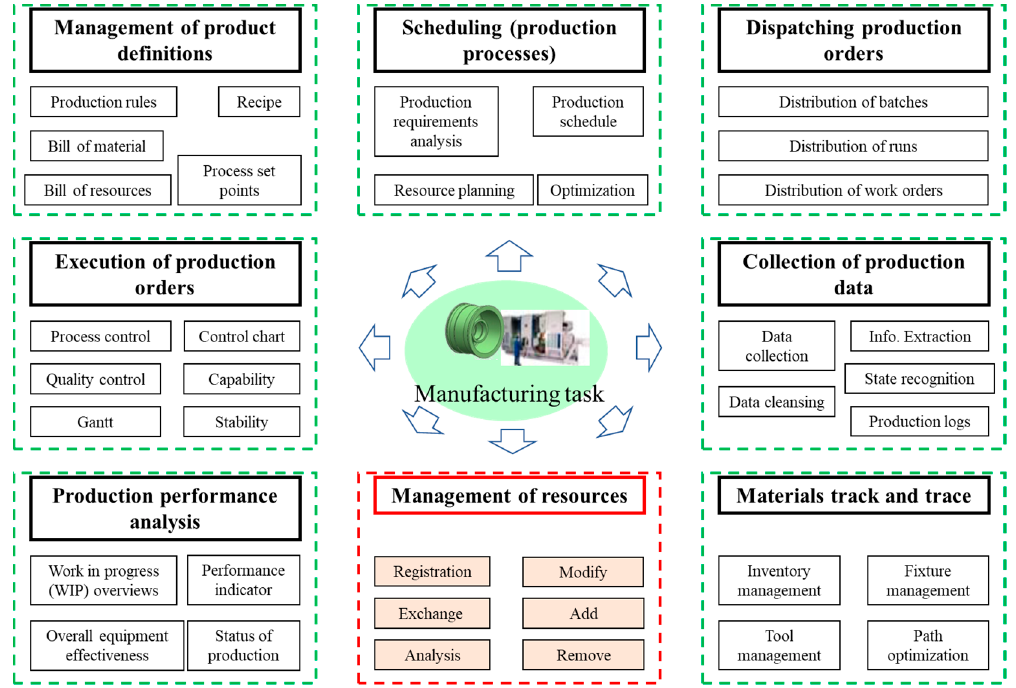
Figure 6. Functional decomposition of manufacturing task.